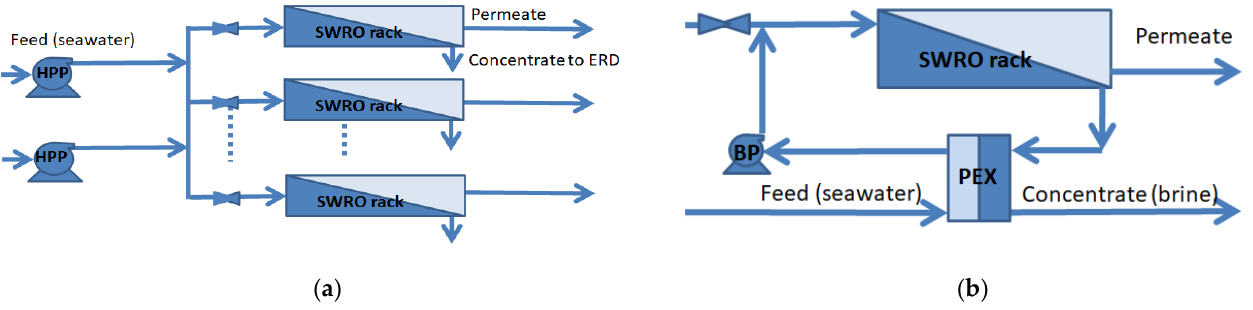
Figure 6. ( a ) Conceptual diagram of two high pressure pumps (HPP) that can be connected or disconnected or coupled in parallel for driving a variable number of membrane racks in operation. Energy recovery devices (ERD) should be installed. ( b ) Conceptual diagram of a SWRO rack when selecting Pressure EXchangers (PEX) as the ERD. The unit PEX means an array of PEXs coupled in parallel.